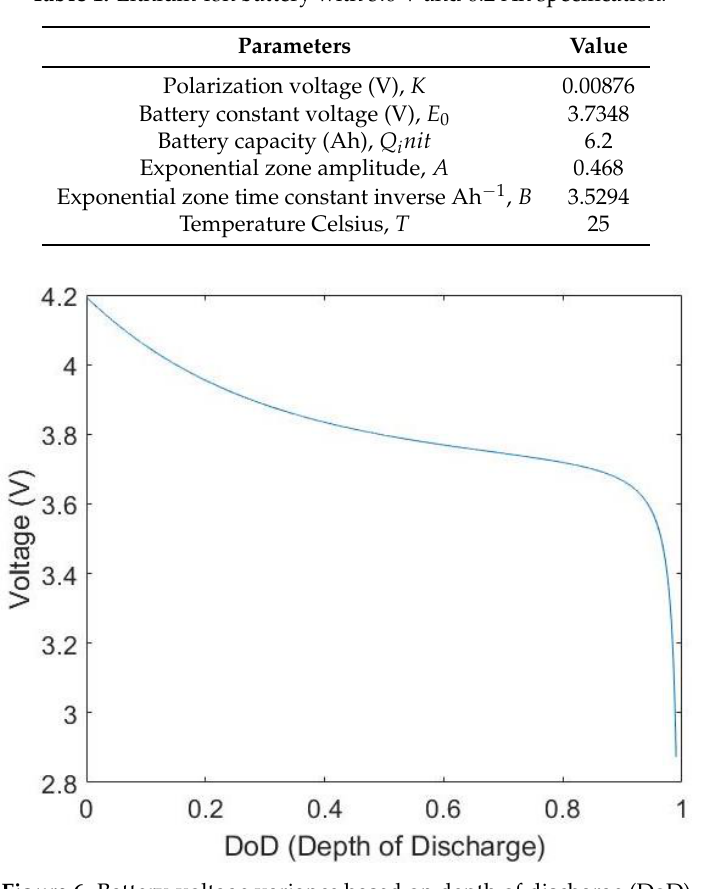
Table 1. Lithium-ion battery with 3.6 V and 6.2 Ah specification.